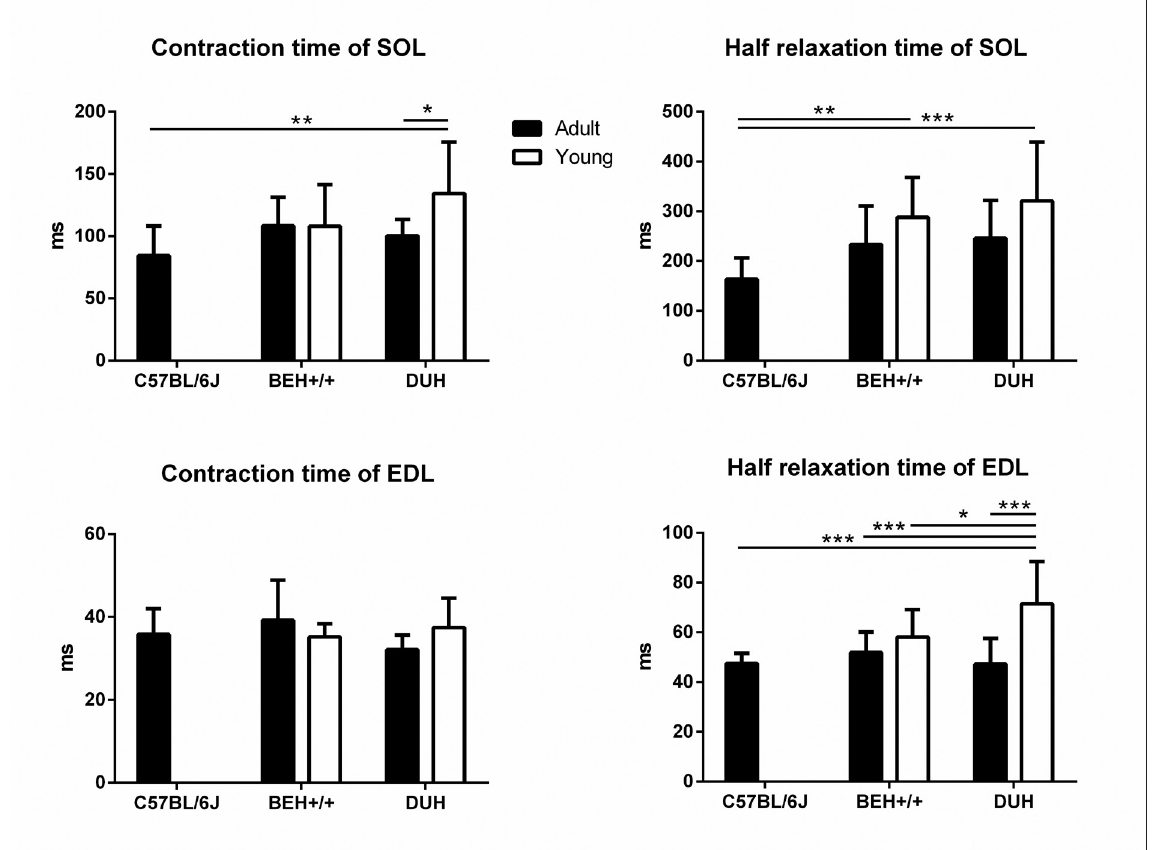
Figure 2. Twitch velocities of soleus (SOL) and extensor digitorum longus (EDL) muscles for C57BL/6J, BEH+/+ and DUH strains Note. Values are means ± SD . * p < .05, ** p < .01, *** p < .001,